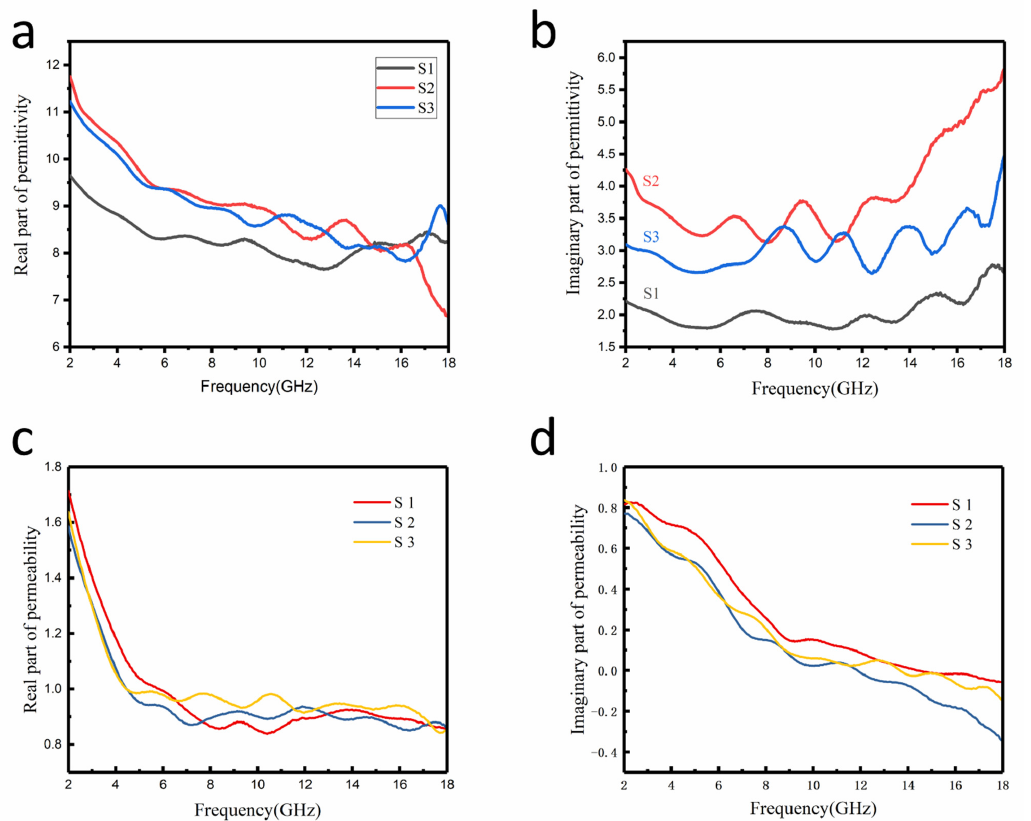
Figure 5. ( a ) Real part of the permittivity. ( b ) The imaginary part of the permittivity. ( c ) Real part of permeability. ( d ) The imaginary part of permeability.